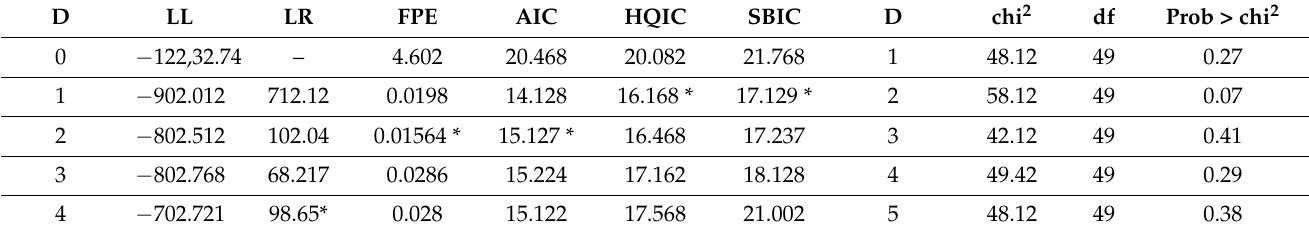
Table A2. Test for VARX and Lagrange multiplier test for autocorrelation of fitted VARX model.